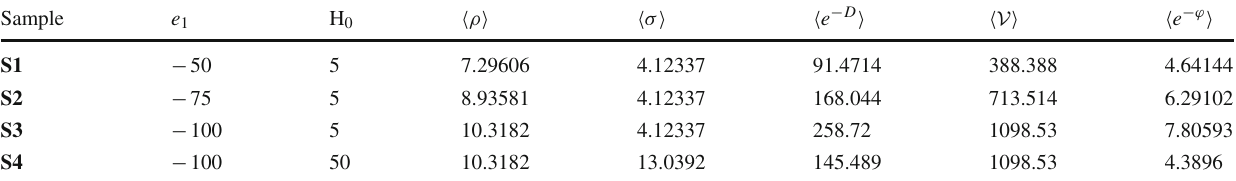
Table 3 Numerical samplings corresponding to the Minkowskian solution, i.e. (cid:10) V 0 (cid:11) = 0. Other flux parameters are set as: e 0 = 0 , m 1 = 0 , m 0 = 1 , H 1 = 1, which leads to axions being stabilized as: (cid:10) b 1 (cid:11) = 0 and (cid:10) ξ 0 (cid:11) H 0 + (cid:10) ξ 1 (cid:11) H 1 = 0